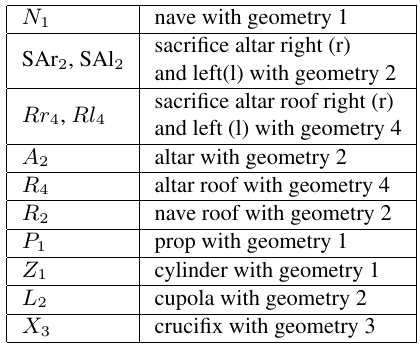
Table 1: ID-names of church